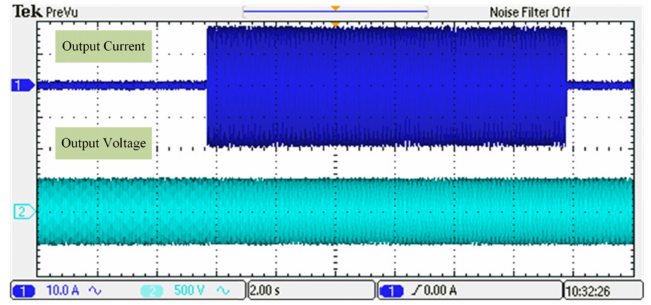
Figure 17. Experimental results of voltage and current in SA mode.